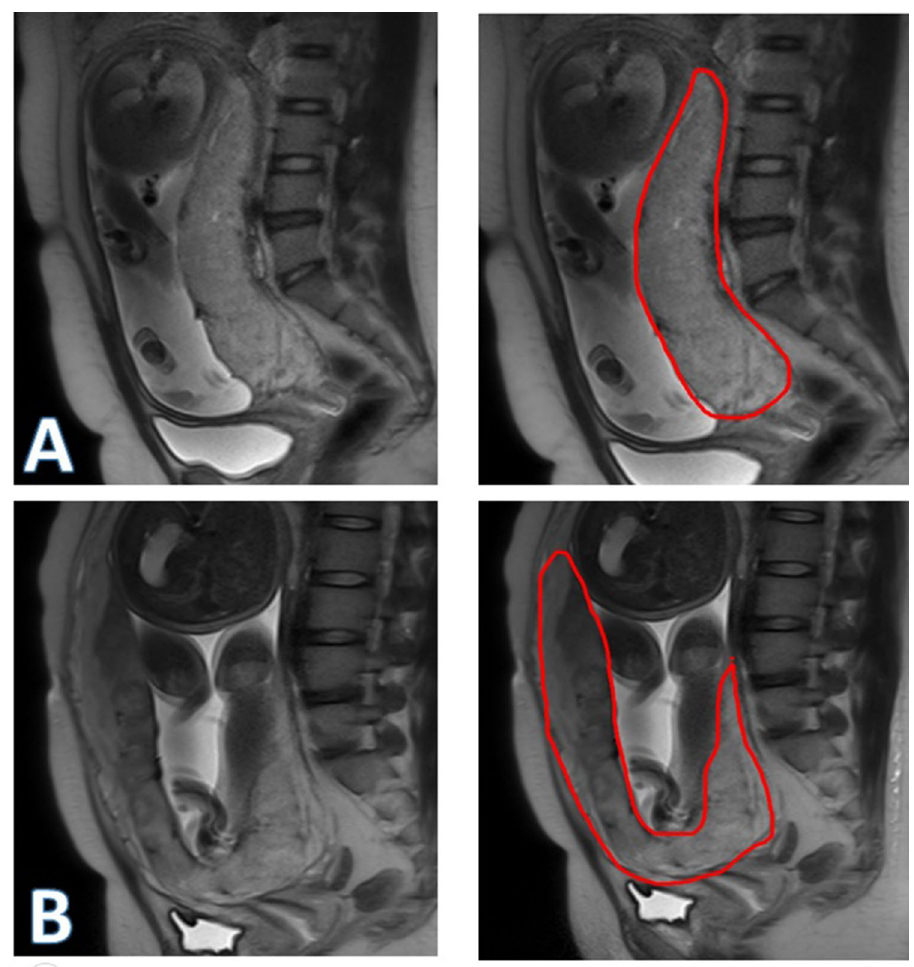
Figure 7. A 29-year-old gravid woman with placenta previa at 34.5 GW ( A ). Both the raw image and the segmented area were displayed on sagittal T2WI. In this case, the model gave the prediction probability of 0.264 in PAS status, representing a false-negative error. A 28-year-old gravid woman with complete placenta previa at 37.2 GW ( B ). The raw image and the corresponding segmented image were also displayed. In this case, the model gave the prediction probability of 0.744 in PAS status, representing a false-positive